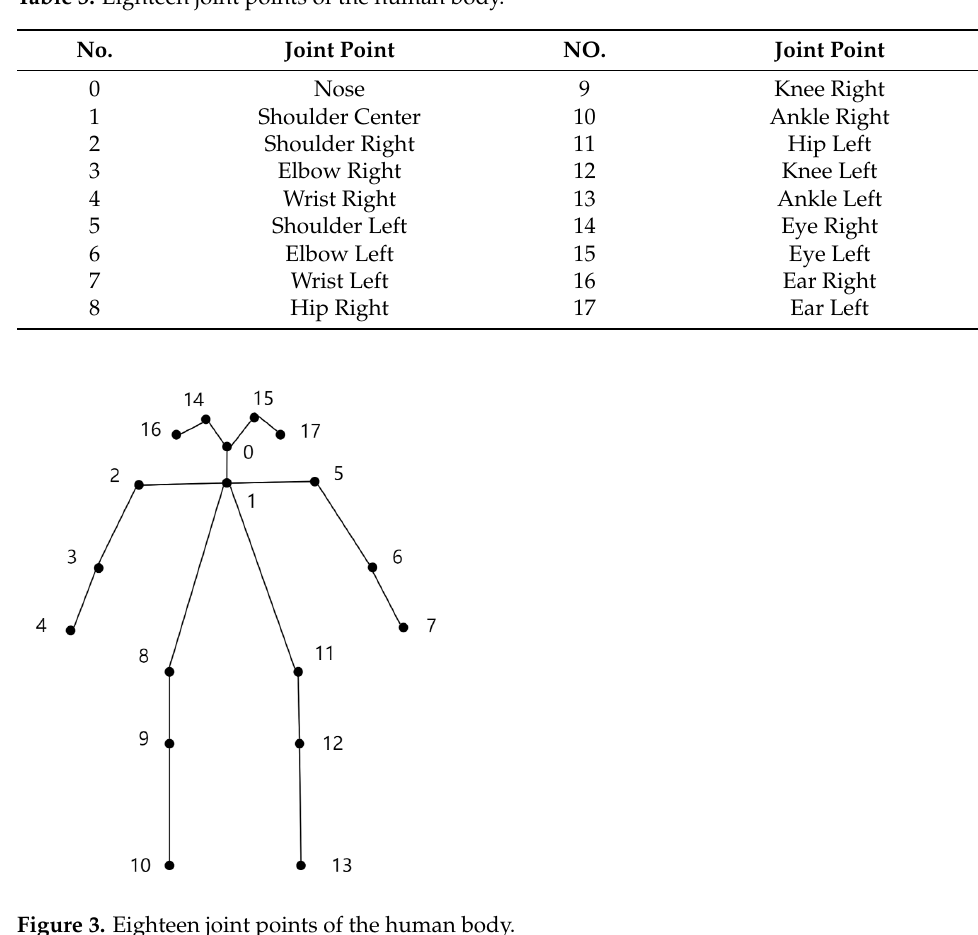
Figure 3. Eighteen joint points of the human